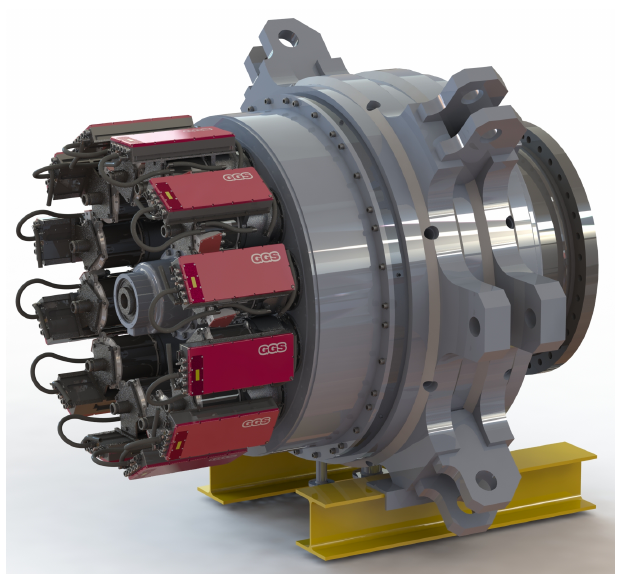
Figure 1. Wind turbine multi-generator drive train with 12 single